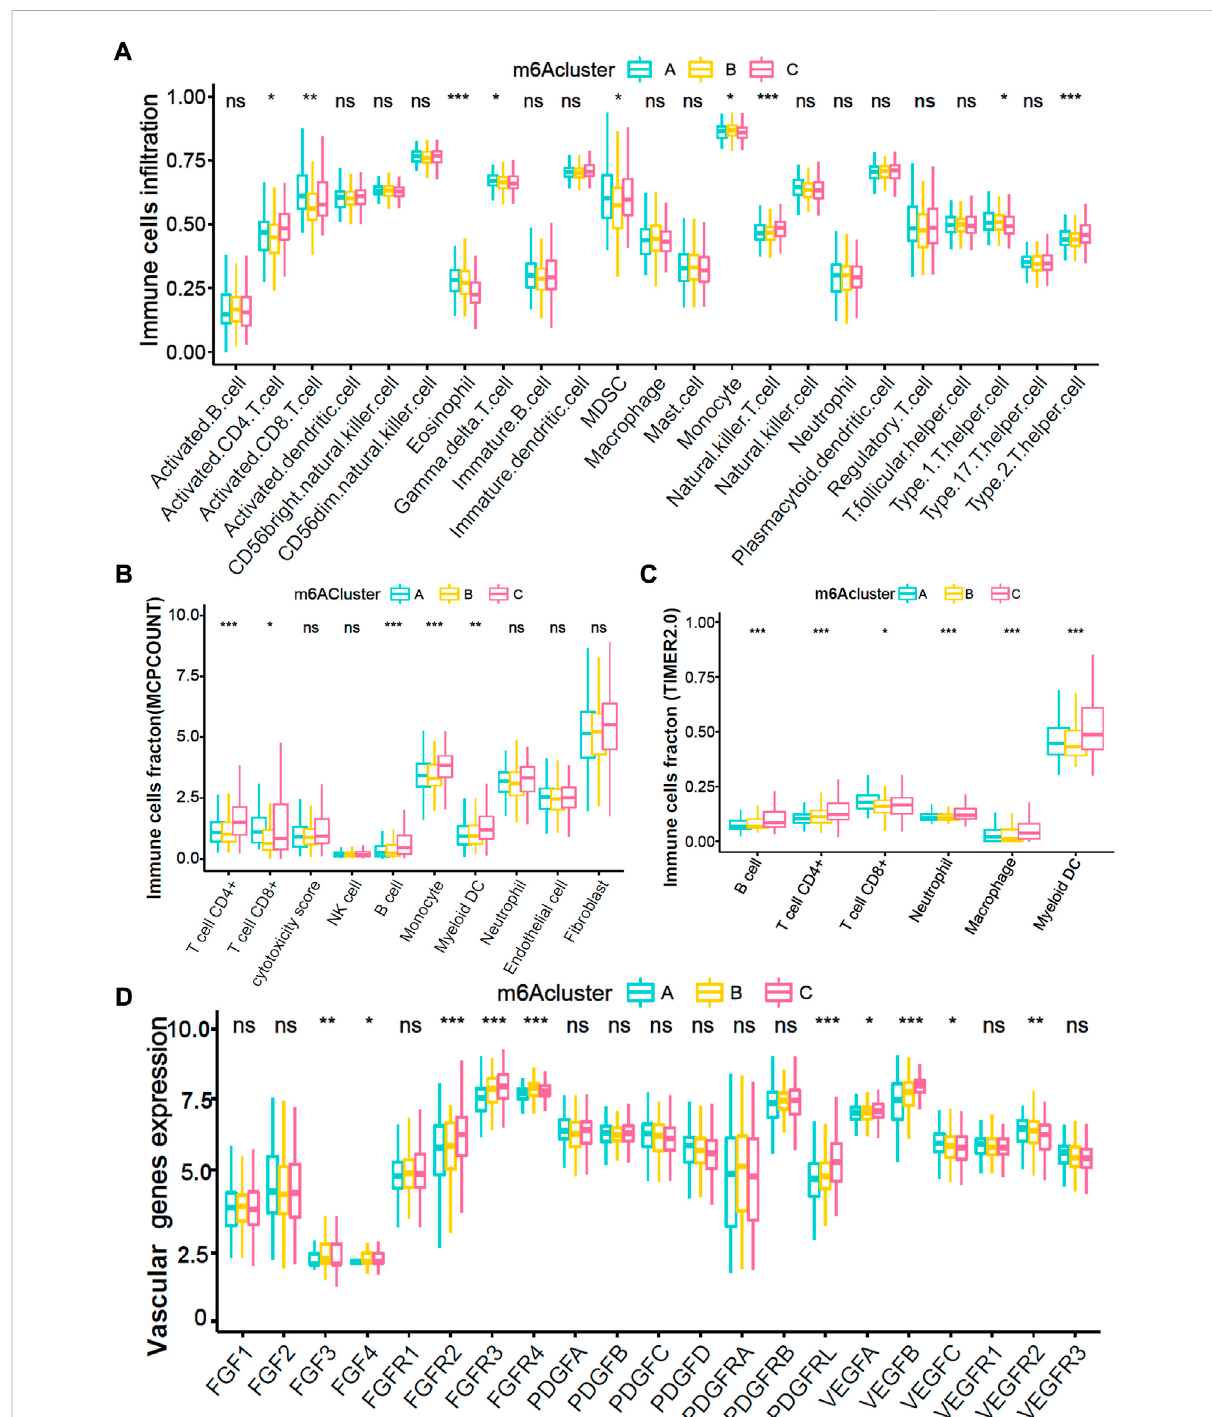
FIGURE 3 Immuneandangiogenesismicroenvironmentcharacteristicsindistinctm6Amodi fi cationpatterns. (A) ThefractionofTMEcellsinthreedistinct m6A-related patterns. (B , C) The abundance of tumor-in fi ltrating immune cells in three m6A-related patterns were calculated via MCPCOUNT and TIMER2.0algorithm.B,CIBERSORT;C,TIMER2.0. (D)